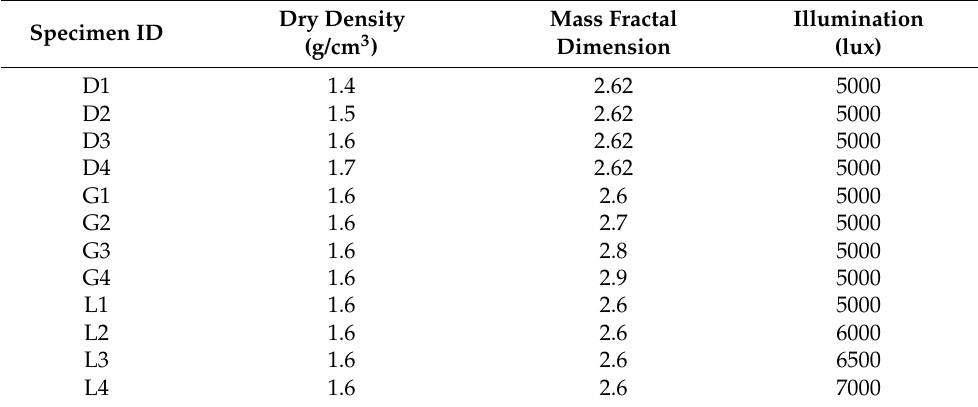
Table 2. Initial parameters of tested loess specimens.